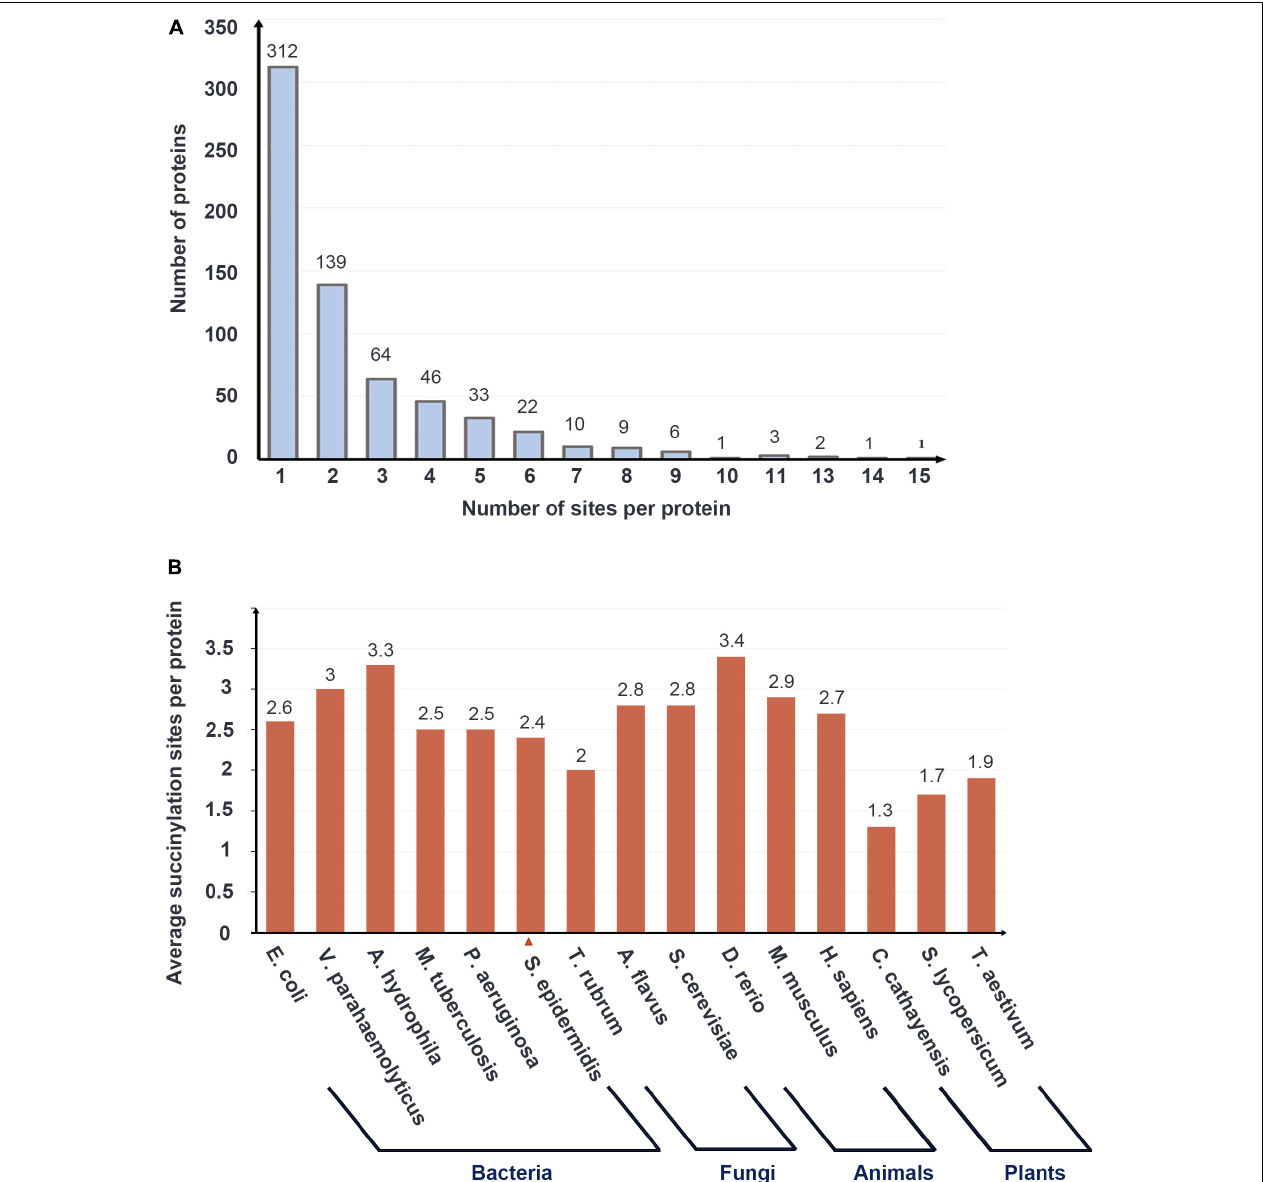
FIGURE 1 | The basic data of LC-MS/MS data and the succinylation profile of Staphylococcus epidermidis. (A) The number of proteins with the various numbers of succinylated sites. (B) Average succinylation sites per protein in bacteria, fungi, animals, and plants.